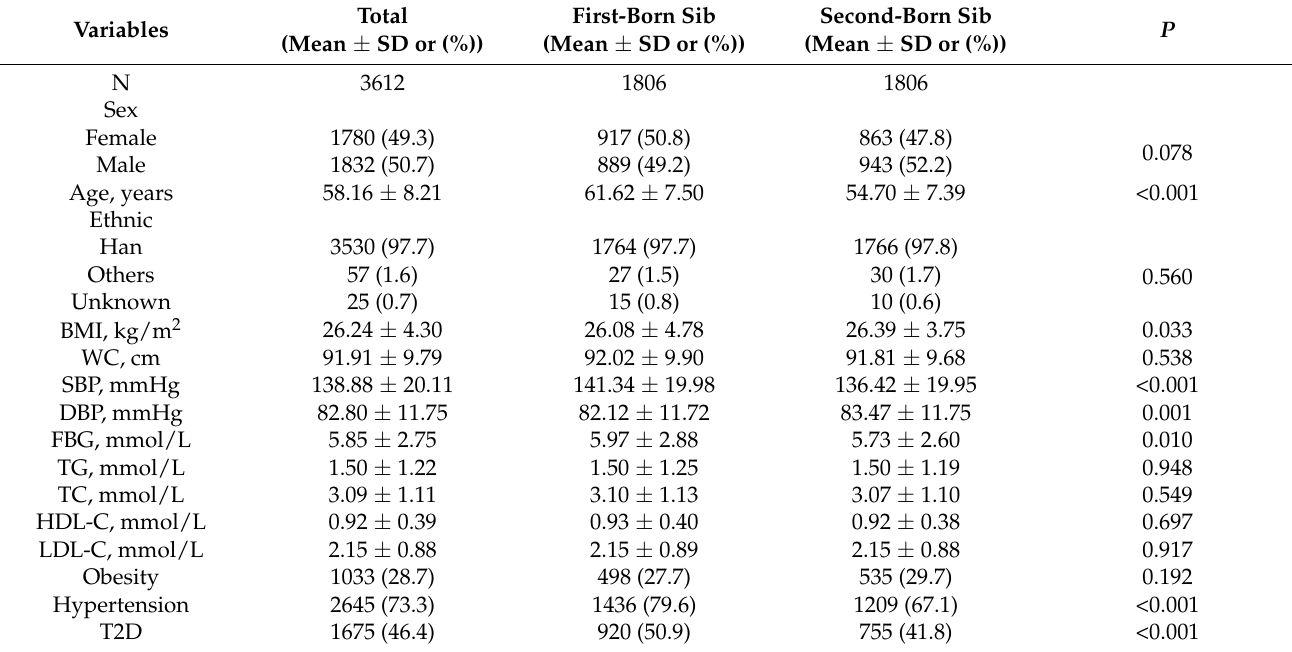
Table 1. Demographic and clinical variables of the subjects of